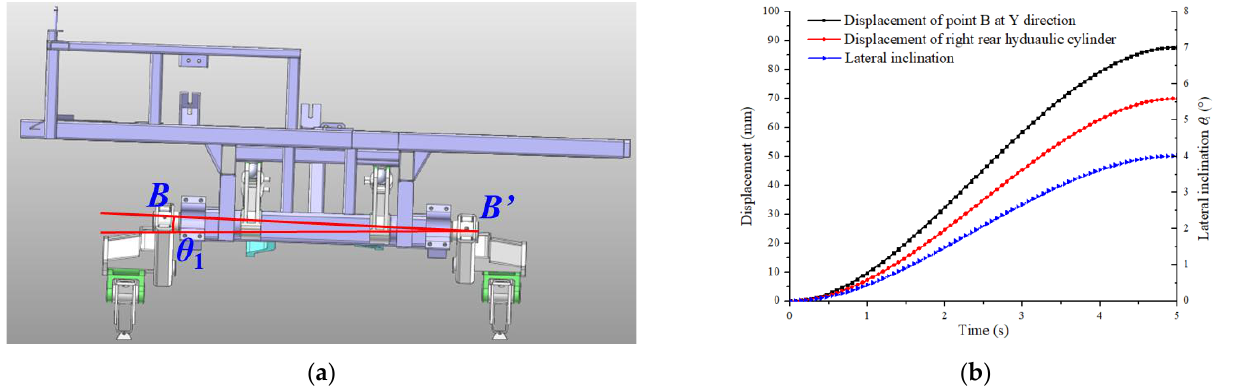
Figure 11. Simulation results of lateral tilting adjustment: ( a ) Left-leaning simulation diagram of chassis. ( b ) Hydraulic cylinder displacement and lateral inclination θ 1 . chassis. ( b ) Hydraulic cylinder displacement and lateral inclination θ 1 .